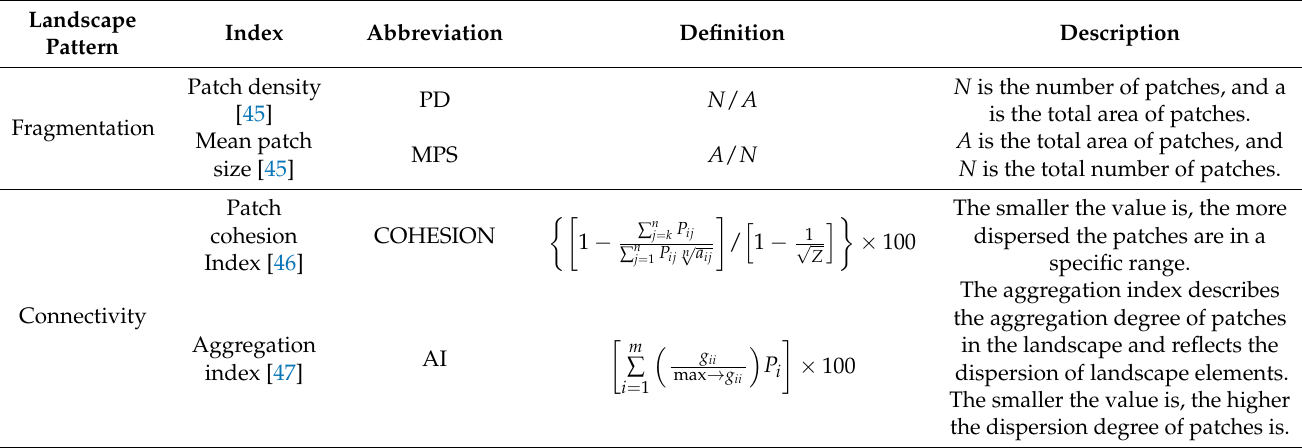
Table 1. Definition and description of landscape pattern index values.